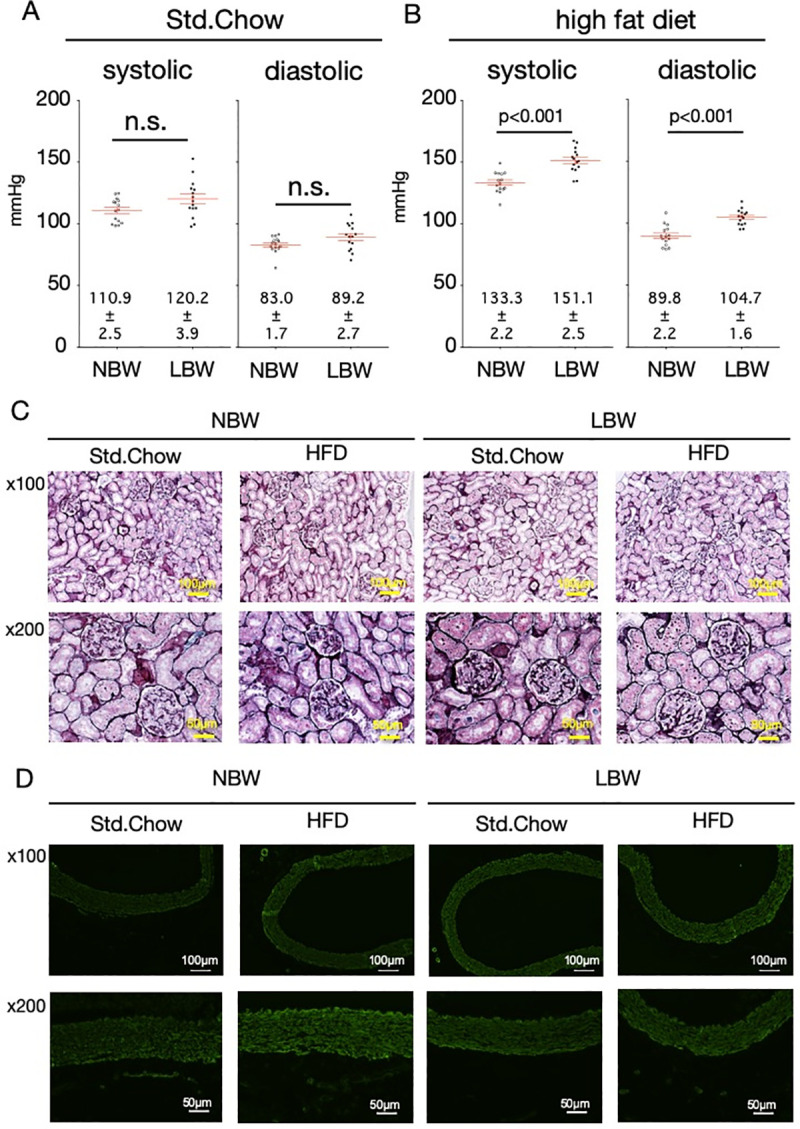
Blood pressure and tissue observations of kidneys and aortas of LBW rats with high-fat diet exposure.LBW rats were exposed to a high-fat diet (HFD) for 8 weeks. Blood pressure was measured by the tail-cuff method. (A) shows control rats (NBW) and LBW rats fed a standard chow, and (B) shows control rats and LBW rats exposed to a high-fat diet (n = 15). Statistical analysis was performed using unpaired T-test. Characteristic kidney PAM staining image and an aortic anti-SMA immunostaining image are shown (C and D).